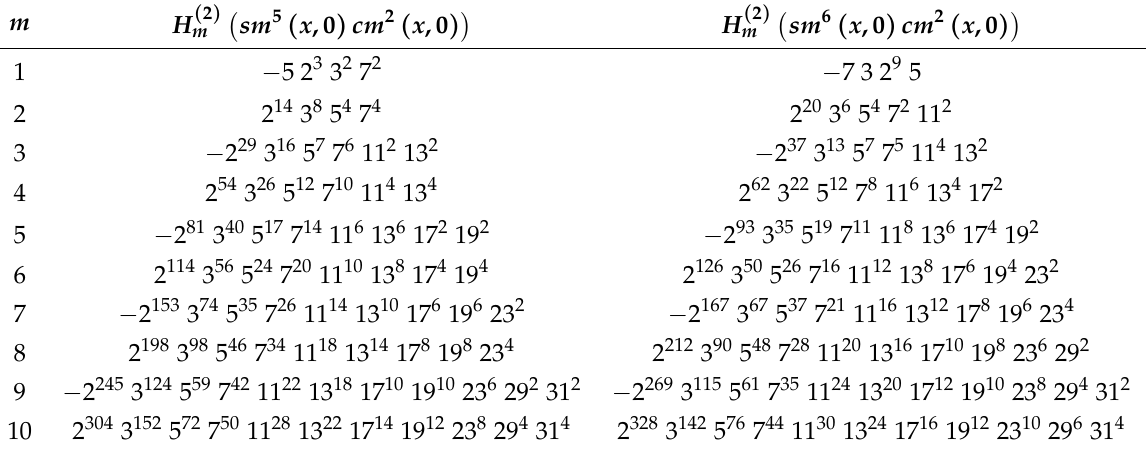
Table 9. Hankel determinants H sm 6 ( x ,0 ) cm 2 ( x ,0 ) for m from